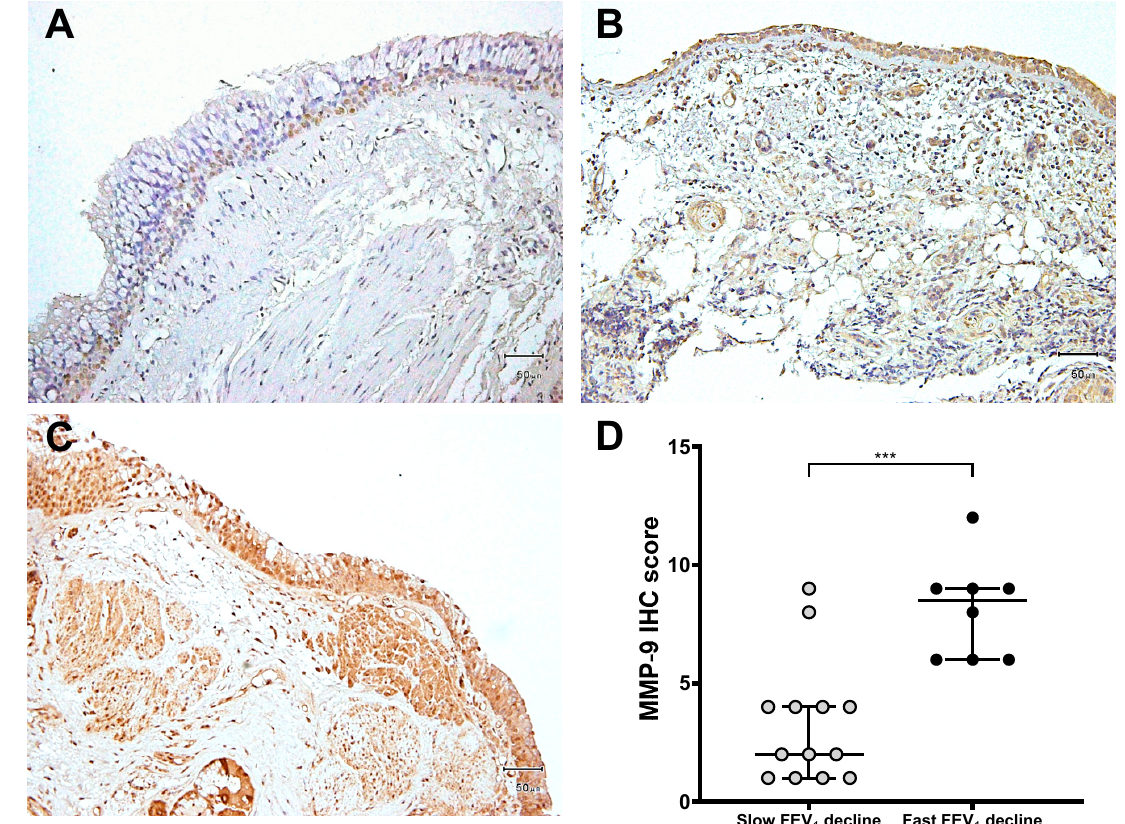
Figure 1. Immunohistochemical expression levels of MMP-9. An avidin–biotin complex immunohistochemical study for MMP-9 labeling was performed in airway tissues obtained from asthmatic patients with a slow FEV 1 decline (A) and a fast FEV 1 decline (B and C). Positive staining was defined as brown–yellow particles or tan–brown particles in the cytoplasm (magnification, 200 × ). ( A ) Airway tissue with weak staining (score 1); ( B ) airway tissue with moderate staining (score 6); ( C ) airway tissue with strong staining (score 12); ( D ) the immunohistochemistry score of MMP-9 was determined through a semi-quantitative assessment by calculating the intensity and percentage of positive cells. The central horizontal lines indicate the median, and the error bars (upper and lower horizontal lines) are the 75th percentile and 25th percentile, respectively, *** p < 0.0001. IHC, immunohistochemistry; MMP-9, matrix metalloproteinase-9.